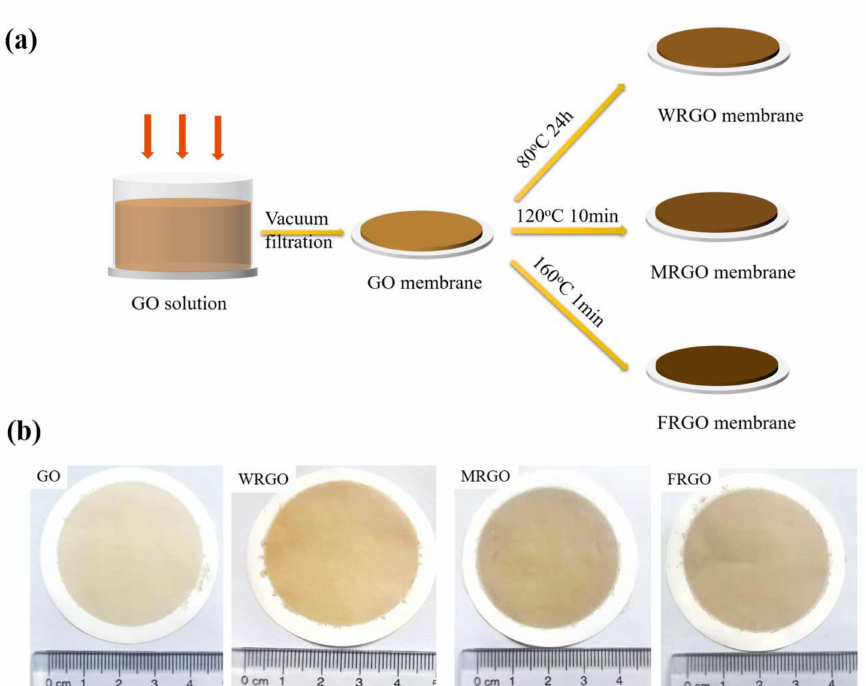
Figure 1. ( a ) Procedure for fabrication and ( b ) photographs of GO membrane, WRGO membrane, MRGO membrane, and FRGO